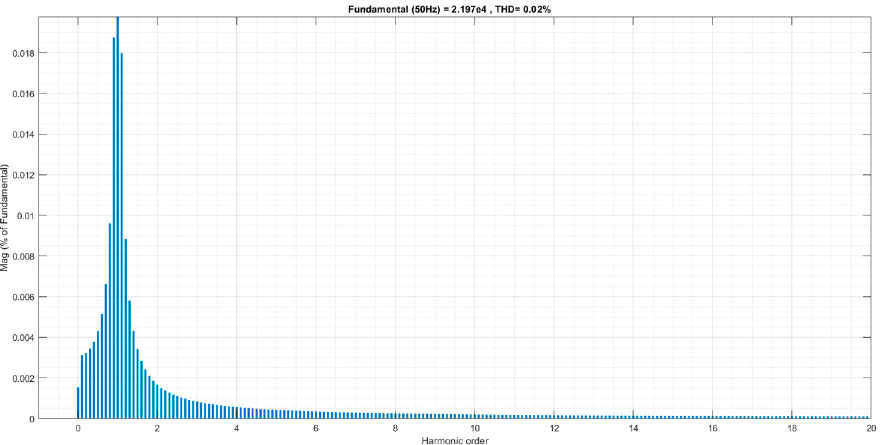
Figure 28. FFT analysis of output power of hydropower plant model.